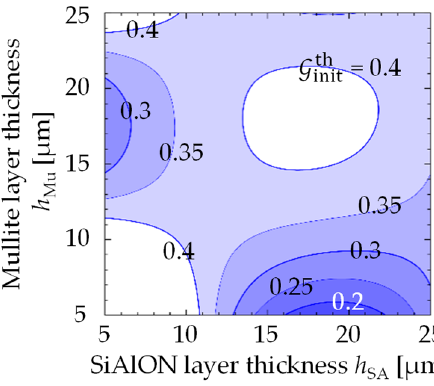
Figure 5. Contour chart of 𝒢 (cid:2919)(cid:2924)(cid:2919)(cid:2930),(cid:2903)(cid:2885)/(cid:2897)(cid:2931)(cid:2930)(cid:2918) (ℎ (cid:2903)(cid:2885) , ℎ (cid:2897)(cid:2931) ) interpolated with Equation (5).